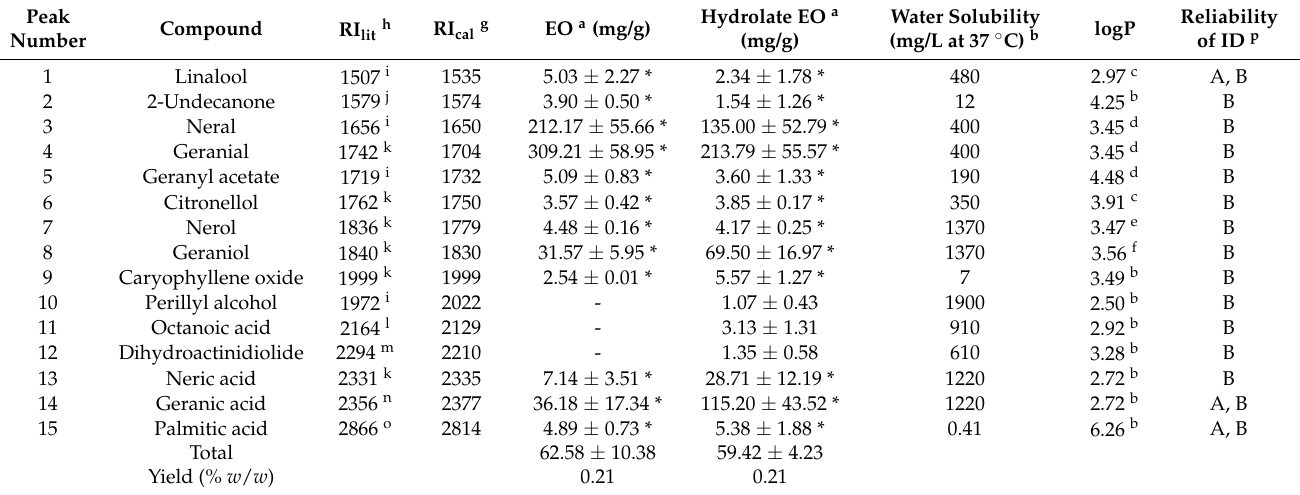
Table 1. Volatile compounds identified in essential oils (EOs) from byproducts of C. citratus leaves obtained by hydrodistillation.